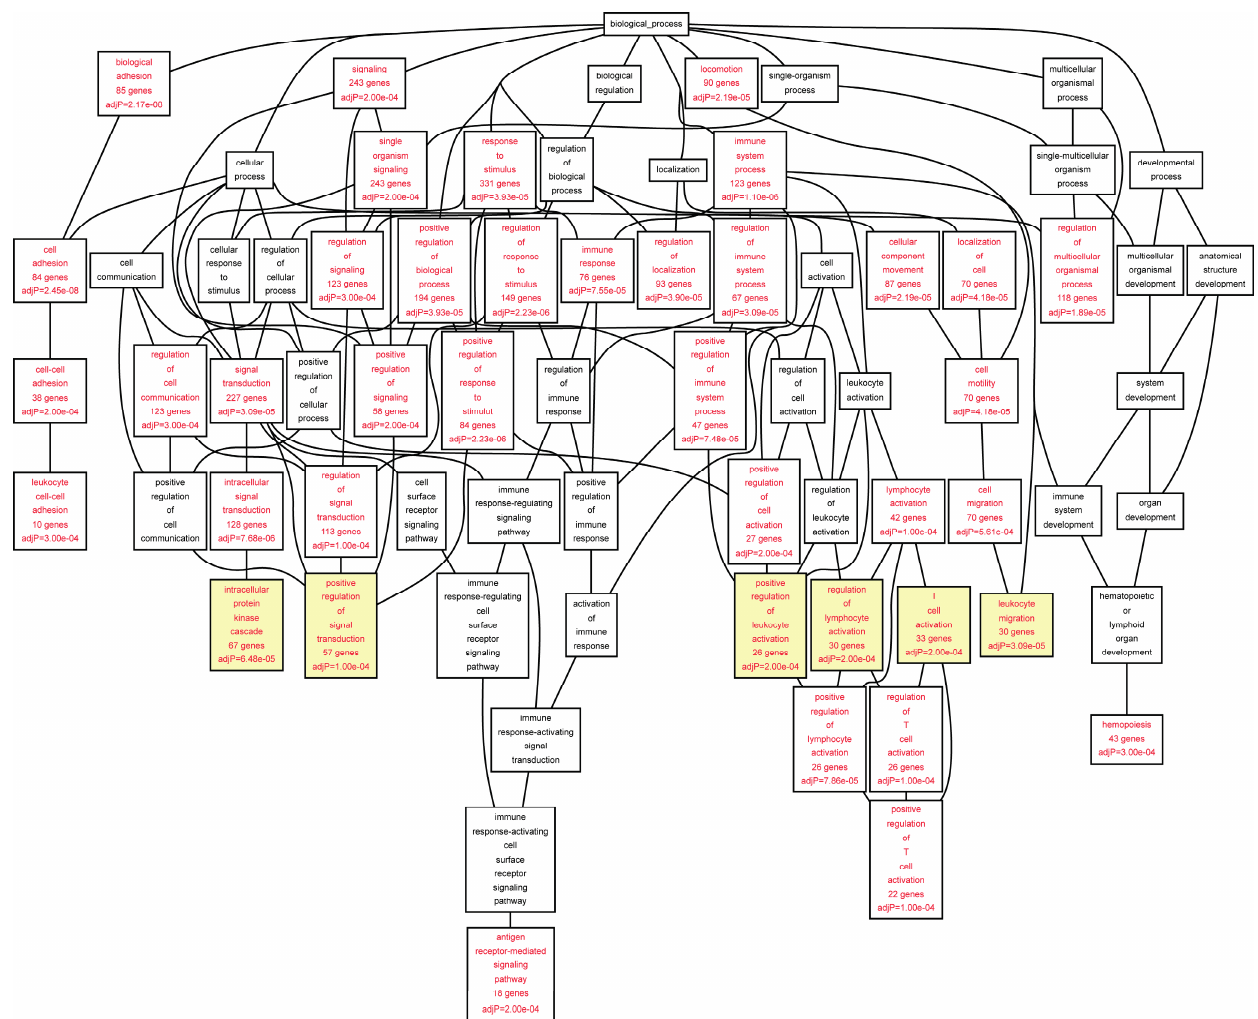
Figure 2. Biological categories of the differentially expressed target genes of transcription factors RUNX1, ELF1, ETS2 and STAT5 in the AAA tissue. A DAG of the GO categories of the set of 711 genes containing at least one cher in AAA tissue was generated by the web application WebGestalt [32]. Categories shown in red were significant (adjusted p < 0.001). The categories on the 6th level of hierarchy are discussed in the text and are shown here with a yellow background. See Tables 5 and S4 for additional